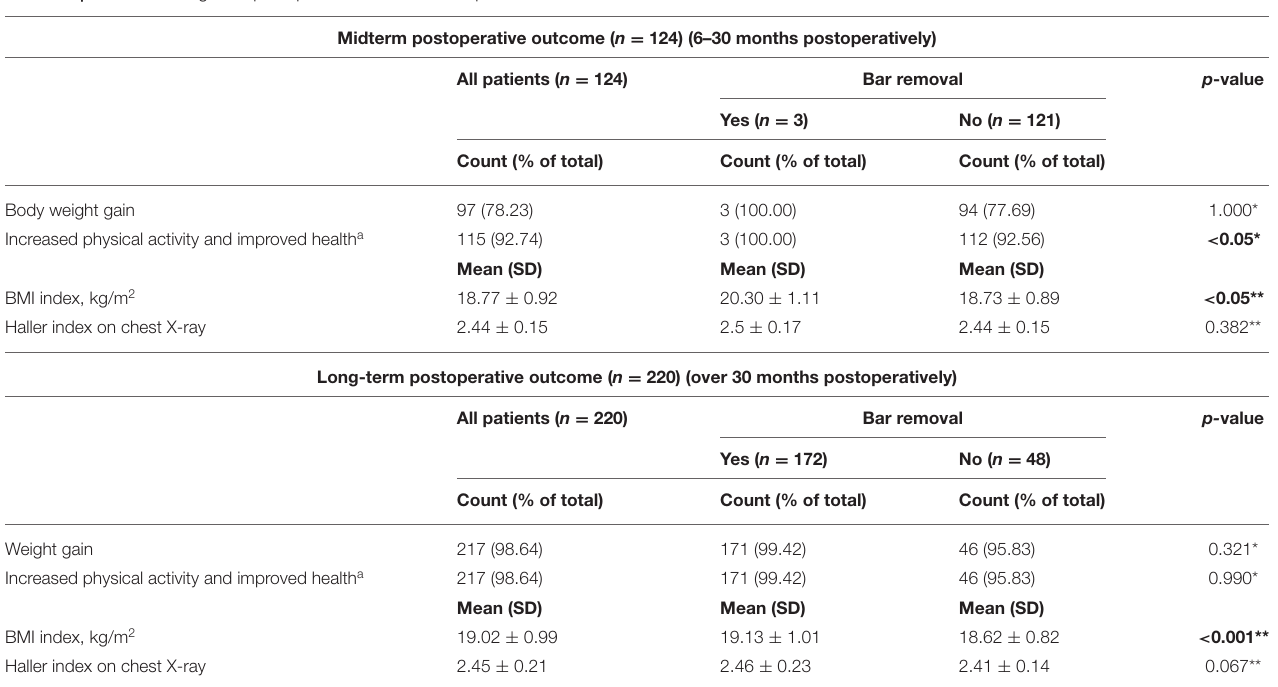
TABLE 5 | Midterm to long-term postoperative outcome in PE